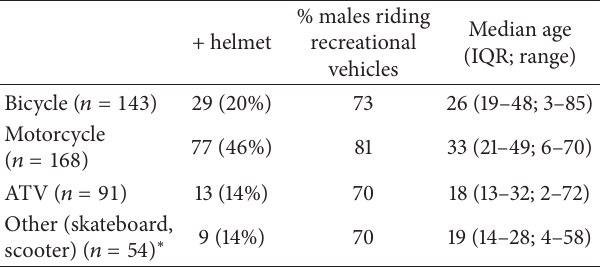
Table 5: Characteristics of riders of different recreational vehicles.